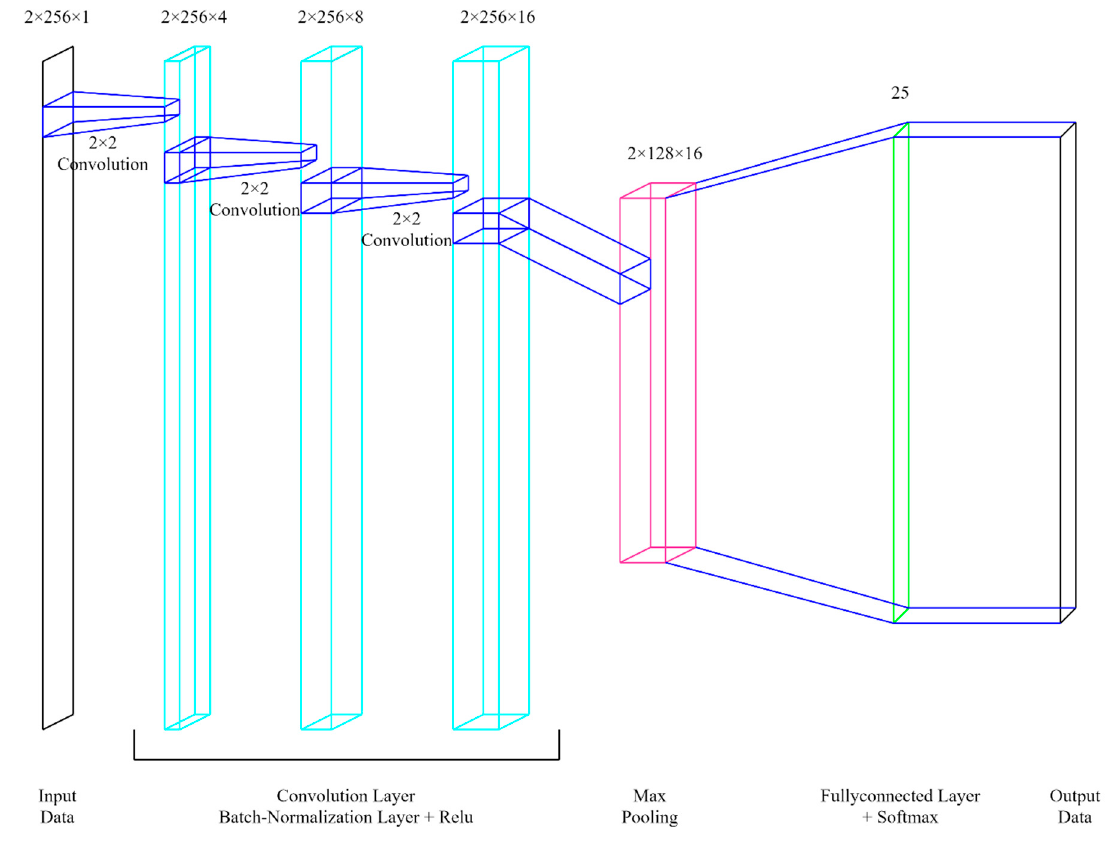
Figure 12. DNN structure.